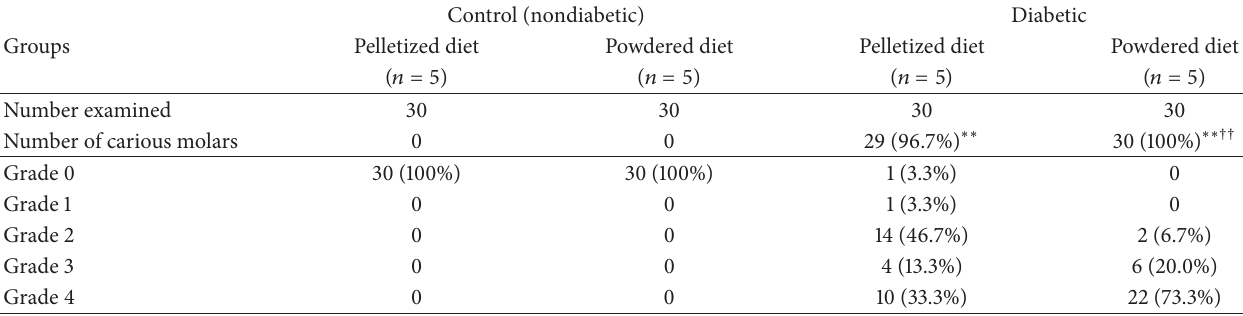
Table 1: Incidence and grading of the carious molars in the mandibles of diabetic rats fed on a pelletized or powdered diet. Control (nondiabetic) Diabetic Groups Pelletized diet Powdered diet Pelletized diet Powdered diet (𝑛 = 5) (𝑛 = 5) (𝑛 = 5) (𝑛 = 5) Number examined 30 30 30 30 Number of carious molars